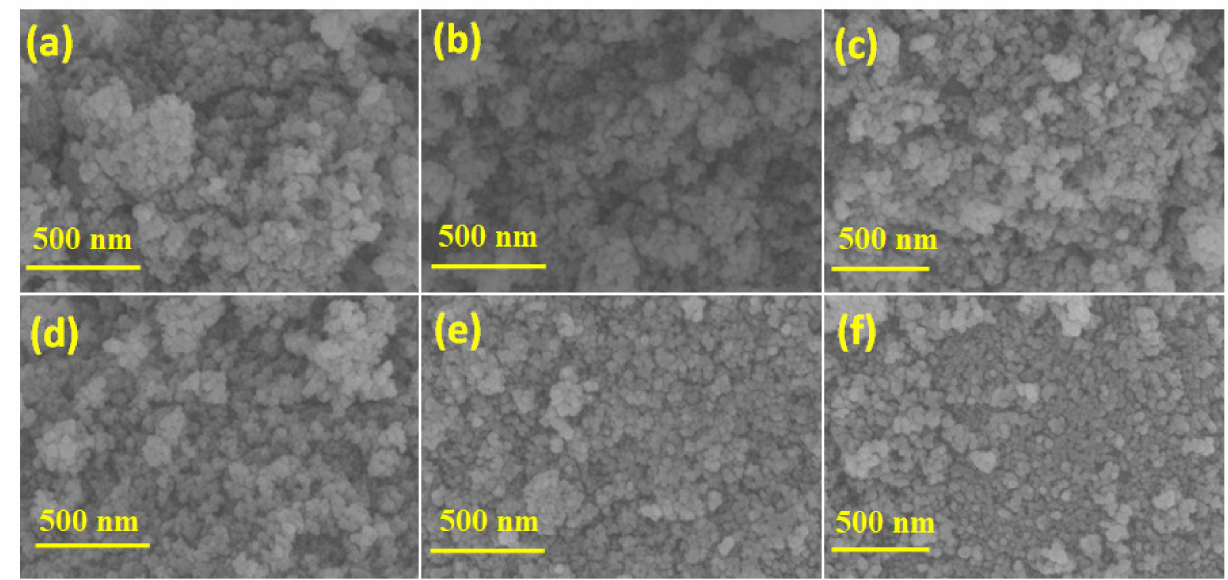
Figure 2. SEM images of as-synthesized TiO 2 –SnO 2 nanocomposites ( a ) TSU95, ( b ) TSU90, ( c ) TSU85, ( d ) TSU80, ( e ) TSU75 and ( f )